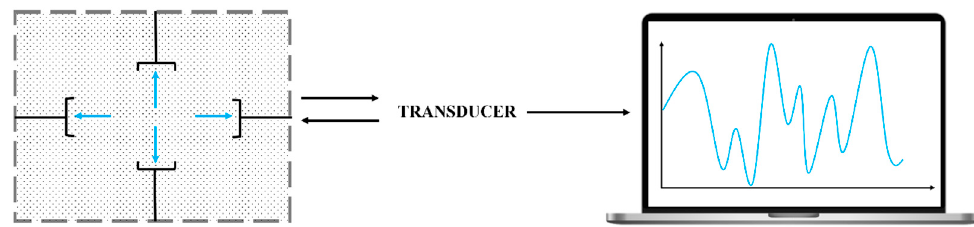
Figure 4. Schematic diagram of operation of MOF-type sensors. Based on: [66].